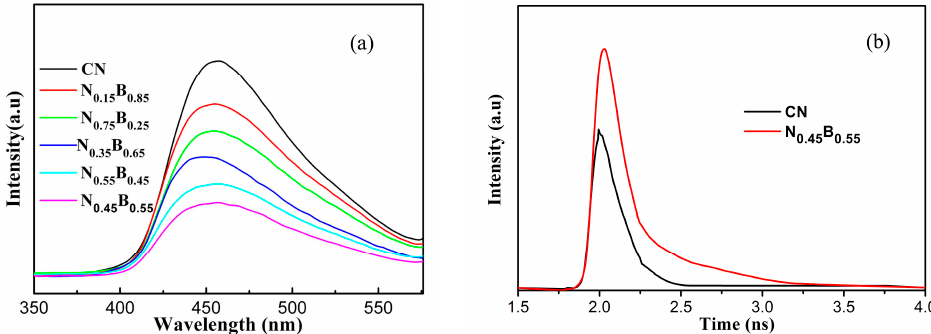
Figure 7. ( a ) PL spectra of g-C 3 N 4 and BC/CN nanocomposites; and ( b ) time-resolved photoluminescence spectra monitored at 480 nm of g-C 3 N 4 and N 0.45 B 0.55